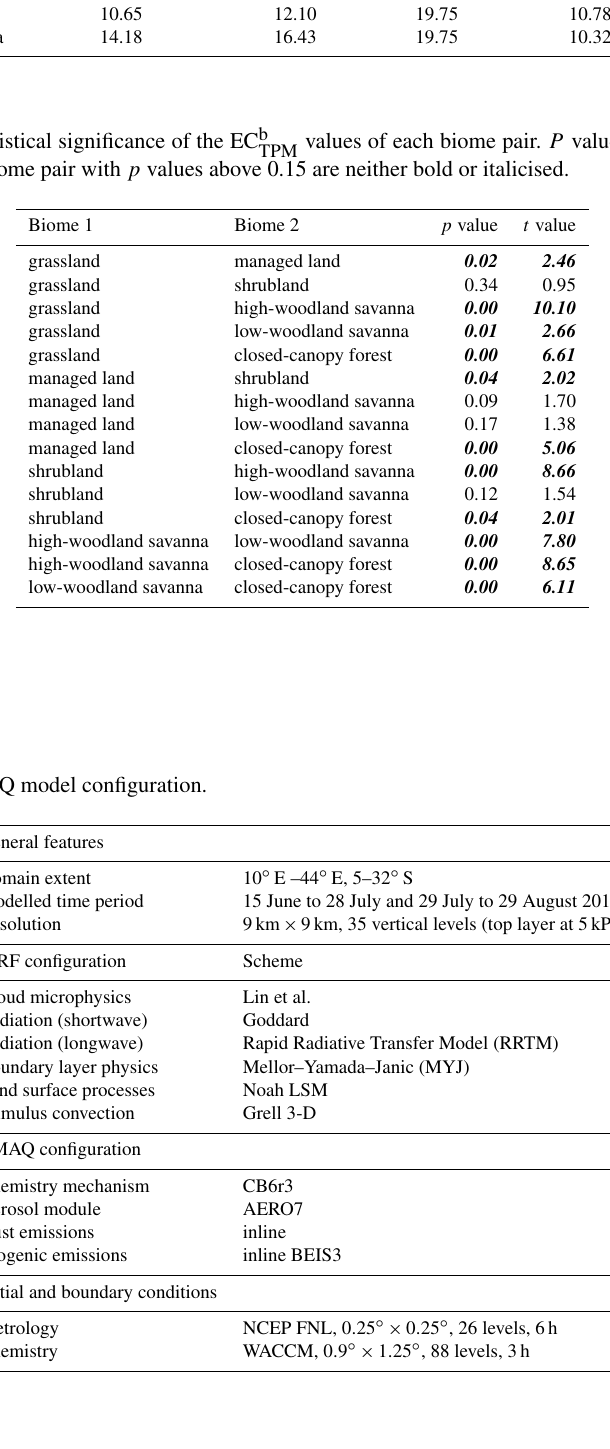
values of each biome pair. P values below 0.05 and those below 0.15 TPM